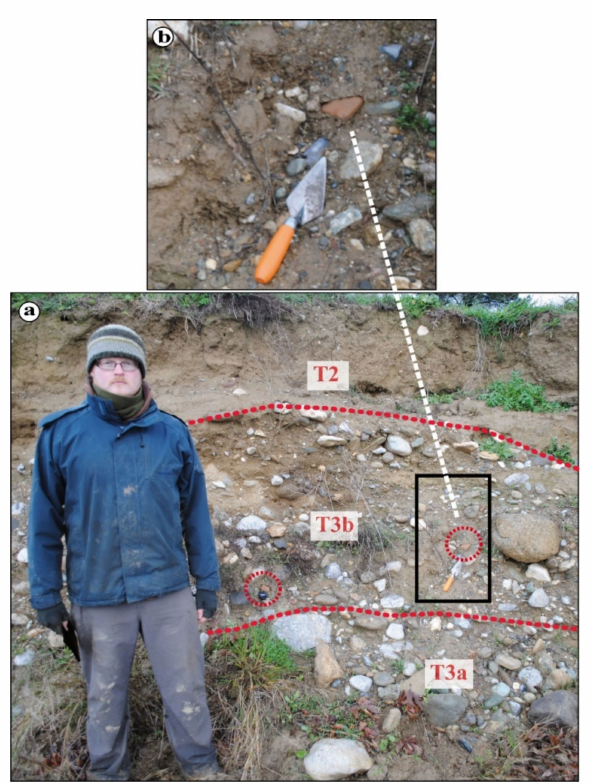
Figure 4. Cross section within the alluvial terraces deposits situated on the right bank of the Lilas river; refer to Figure 3a for exact location; ( a ) view of the different levels of alluvial terraces; ( b ) presence of rounded archaeological material (approx. 5 cm in length and of orange colour) embedded within alluvial terrace T3b sediments (in the picture: A.